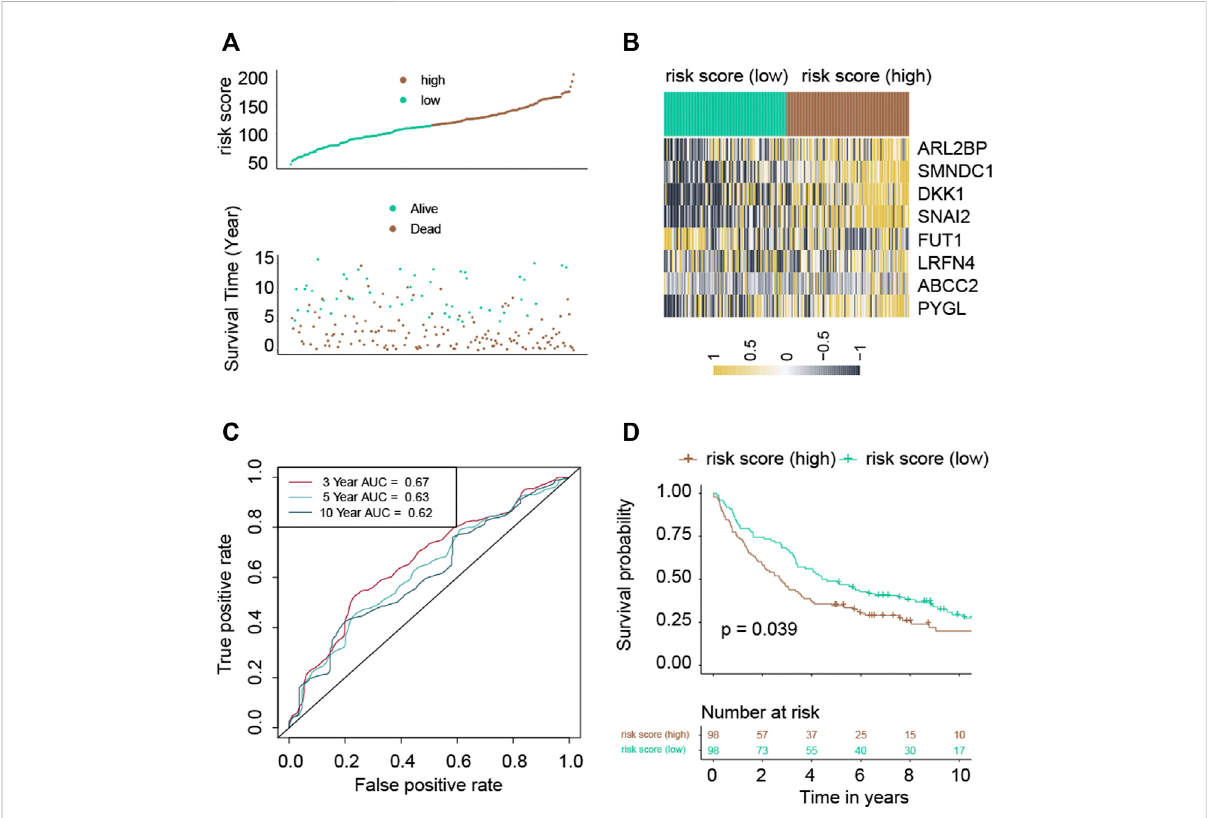
FIGURE 3 Validation of the risk score in the GSE37745 cohort. (A) Distribution of risk scores and survival summary. (B) Heatmap illustrating the expression of the genes in groups with low and high risk. (C) The risk score for predicting survival was assessed by AUC values. (D) There was a reduced overall survival among individuals in the high-risk group compared to patients in the low-risk